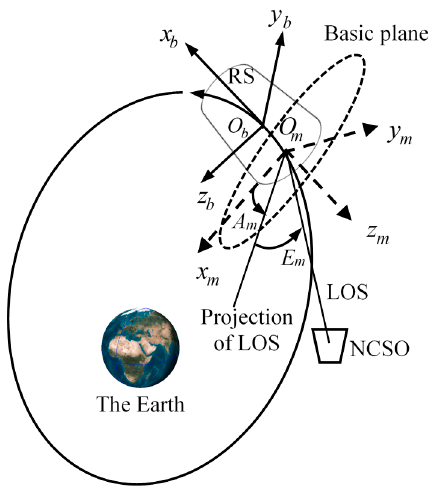
Figure 1. Definitions of earth-centered earth-fixed coordinate system and epoch earth-centered Inertial coordinate system.